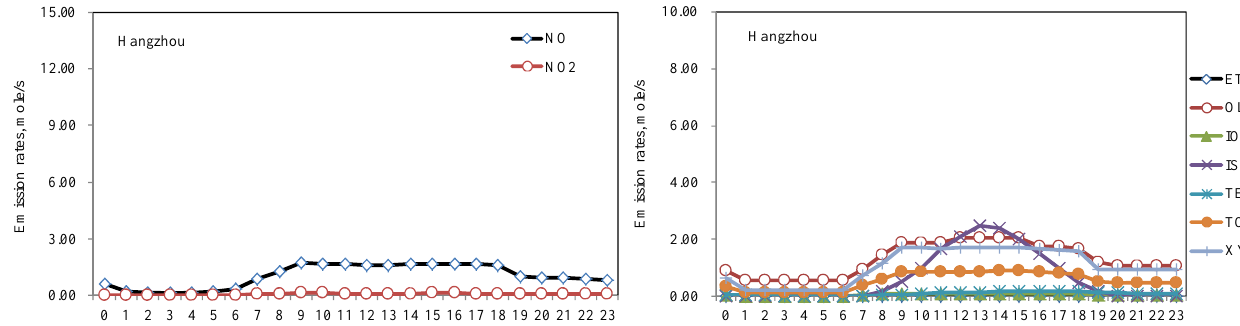
Fig.15. Emission inputs of NO